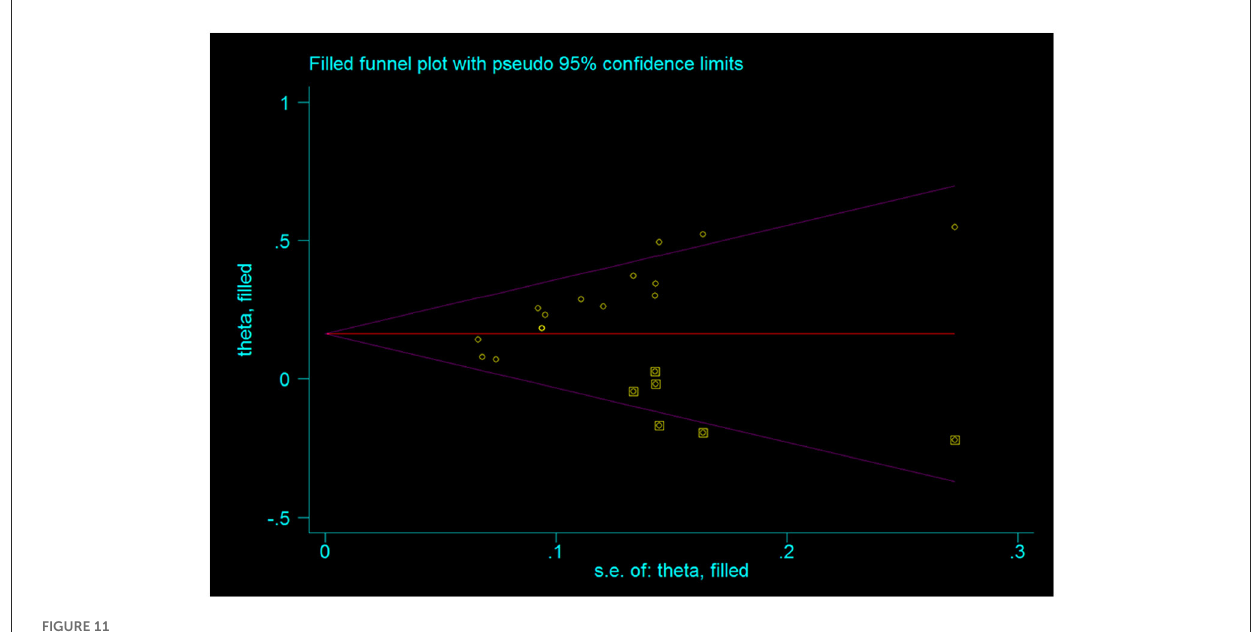
FIGURE11 Funnel chart after